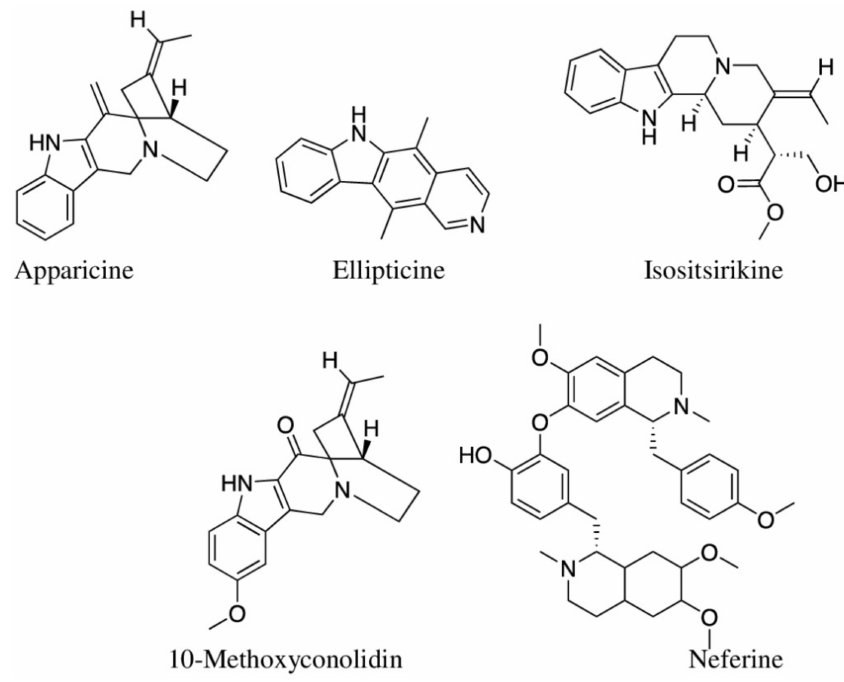
Figure 7. Chemical structures of anti-inflammatory